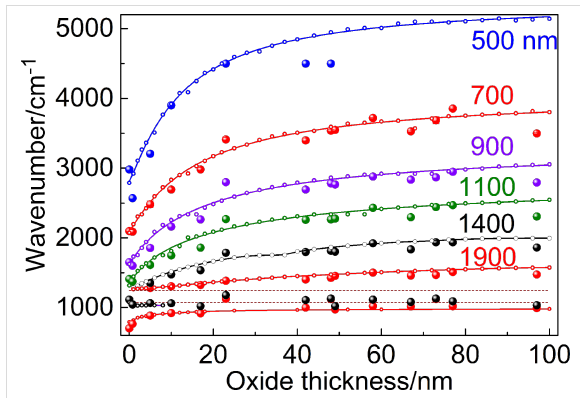
Figure 4: LSPR frequencies of nanoantenna arrays versus the SiO 2 thickness. Six structures with different antenna lengths ranging from 500 to 1900 nm are presented. Large circles: experiment; solid lines with dots: full-wave